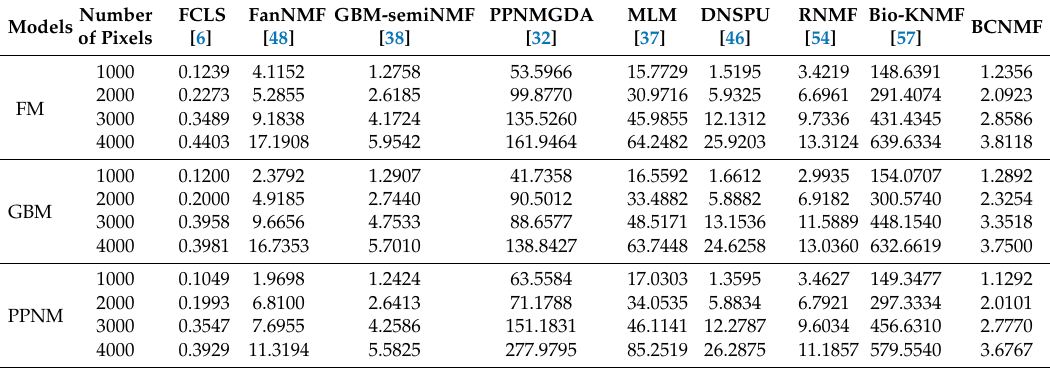
Table 10. Time cost comparison of the algorithms